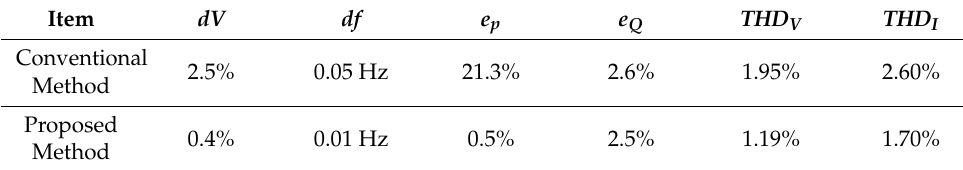
Table 3. Comparison results in steady-state for the nominal